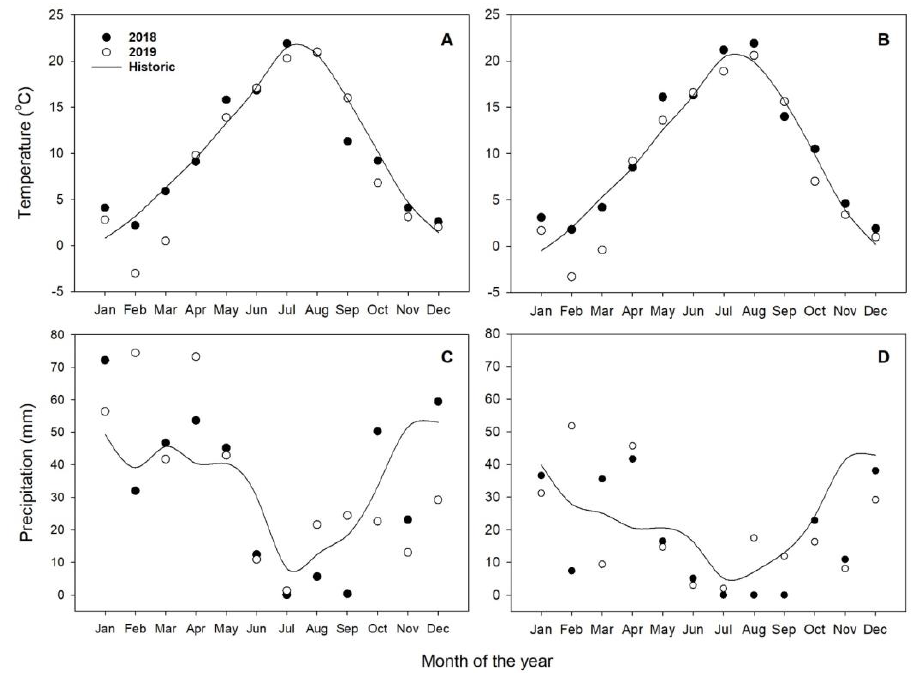
Figure 1. Annual temperature and precipitation for Pendleton ( A , C ) and Moro ( B , D ) in 2018 (black circles) and 2019 (open circles). Historic data (solid line) date back to 1932 in Pendleton and 1897 in Moro. Russian thistle emergence differed between years, sites, crops, and their interaction (Table 1). Pendleton, in 2018, had the highest emergence (55.5 plants m −2 ), and Moro, in 2019, had the lowest emergence (9.1 plants m −2 ). Higher rainfall was likely a primary driver of higher emergence in Pendleton compared to Moro. In Lind, WA, an area that receives approximately 248 mm yr −1 of rainfall, Russian thistle density in spring wheat was 2.2 times lower in two years that received an average rainfall of 215 mm compared to a year that received 356 mm when averaged across treat- ments [2]. Russian thistle density decreased in all plots during the growing season. Plant mortality differed between crops and the interaction between year × site or year × crop (Table 1). Russian thistle mortality was higher in spring barley (48%) compared to spring wheat (37%). Similarly, Borger et al. [17] found that barley suppressed L. rigidum plant density and biomass to a greater extent compared to wheat in two of three sites in one year. These authors also demon- strated that photosynthetically active radiation was lower in barley in the inter-row space,